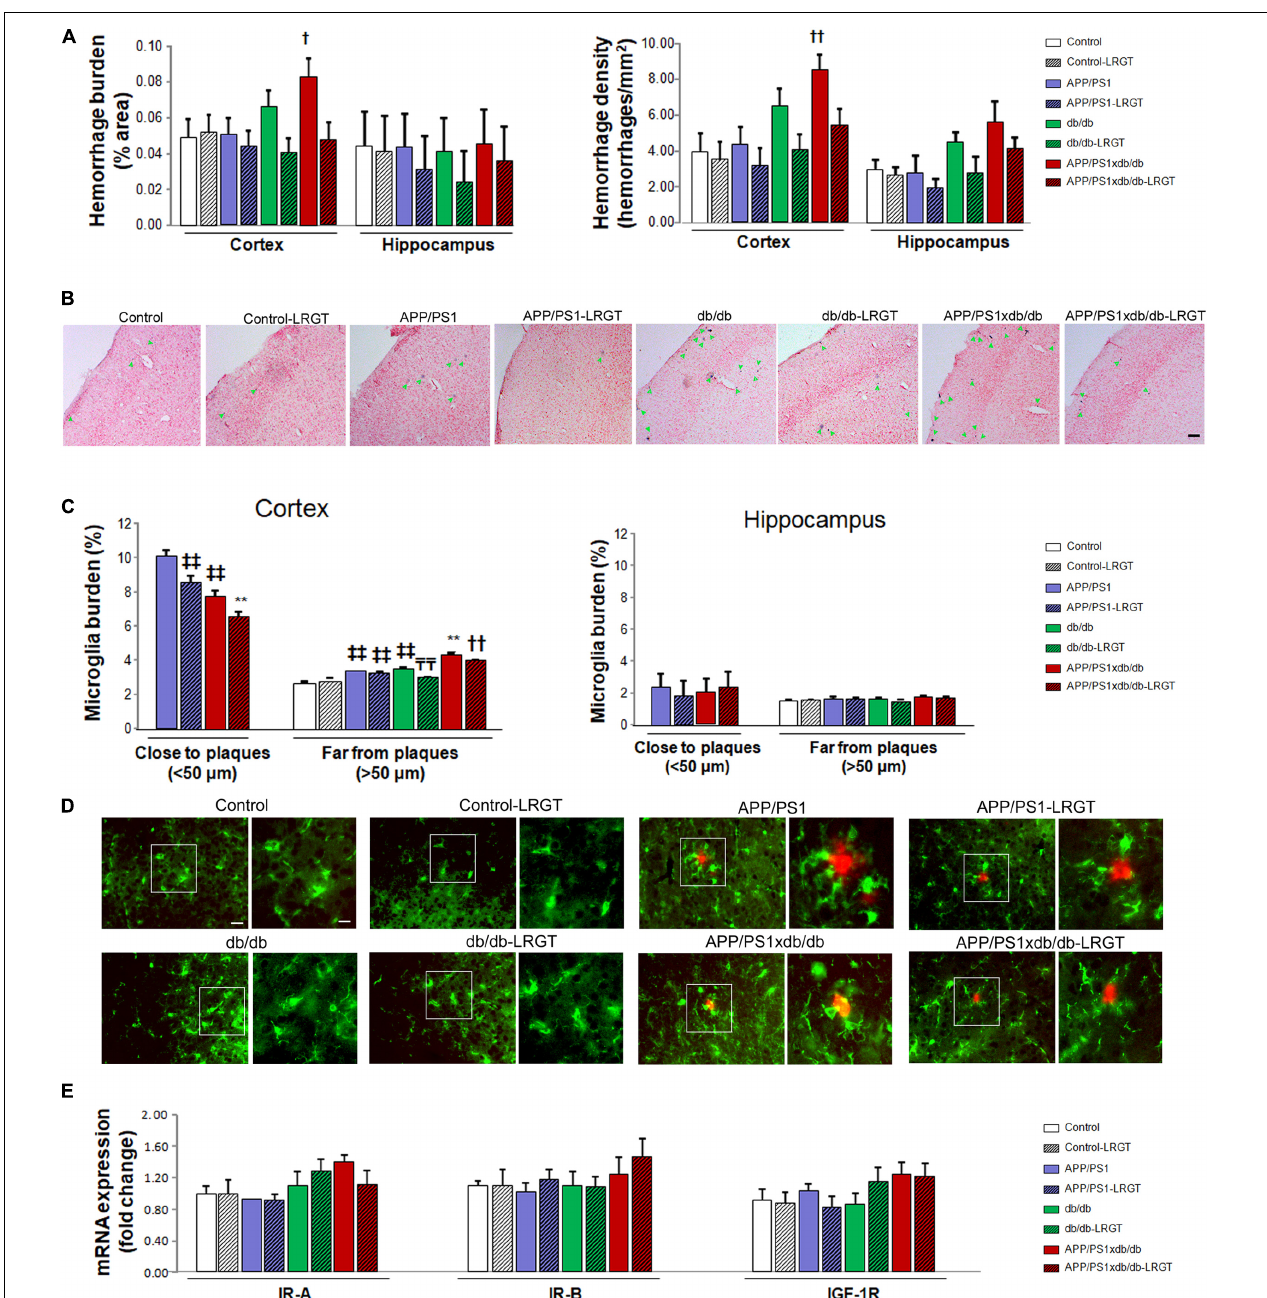
FIGURE 5 | Spontaneous bleeding and inflammation are reduced after LRGT treatment while IR-A, IR-B, and IGF-1R mRNA expression is not affected. Prussian blue staining is used to quantify hemorrhage burden and density in the cortex from untreated and treated mice (LRGT, 500 µ g/kg/day) (A,B) . Microglia burden was quantified by Iba1 immunostaining in the proximity of ( < 50 µ m) and far ( > 50 µ m) from amyloid plaques in untreated and LRGT-treated animals (C,D) . IR-A, IR-B, and IGF-1R mRNA expression is also determined in the cortex from untreated and LRGT-treated mice (E) (complete statistical analysis included as a Supplementary Material ). (A) LRGT treatment reduces hemorrhage burden in the cortex ( † p = 0.012 vs. Control, Control-LRGT, APP/PS1, APP/PS1-LRGT, db/db-LRGT, and APP/PS1xdb/db-LRGT). A similar profile was observed when we analyzed cortical hemorrhage density ( †† p < 0.001 vs. Control, Control-LRGT, APP/PS1, db/db-LRGT, and APP/PS1xdb/db-LRGT). No differences were detected in the hippocampus when hemorrhage burden or density was analyzed. Data are representative of 3–5 mice (489–1,012 hemorrhages/group). (B) Illustrative example of cortical hemorrhages stained with Prussian blue. Green arrows point at individual hemorrhages. Scale bar = 100 µ m. (C) LRGT treatment reduced cortical microglia burden in APP/PS1 and APP/PS1xdb/db mice, in the proximity of amyloid plaques (** p < 0.01 vs. rest of the groups, p < 0.01 vs. APP/PS1). LRGT also reduced microglia burden in cortical amyloid plaque-free areas in diabetic mice (** p < 0.01 vs. rest of the groups, †† p < 0.01 vs. Control, Control-LRGT, APP/PS1, APP/PS1-LRGT, db/db, and db/db-LRGT, p < 0.01 vs. Control, Control-LRGT, APP/PS1, APP/PS1-LRGT, and db/db, p < 0.01 vs. Control and Control-LRGT). No statistical differences were observed in the hippocampus